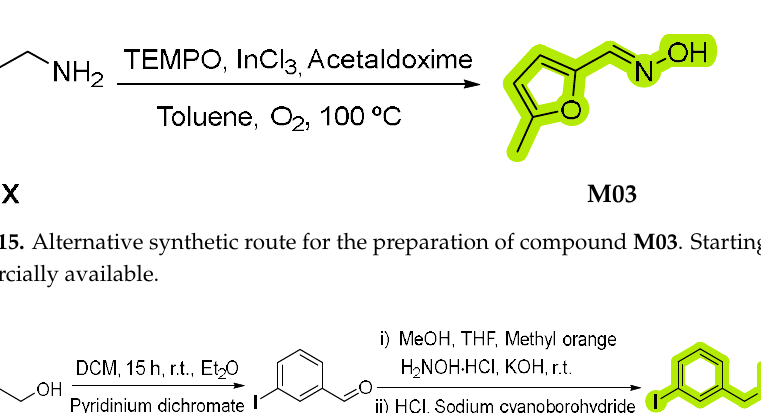
Figure 15. Alternative synthetic route for the preparation of compound M03 . Starting material IX is commercially available. Figure 16. Synthetic route for the preparation of MO4 . THF (tetrahydrofuran), Potassium hydroxide, Starting material X is commercially available.